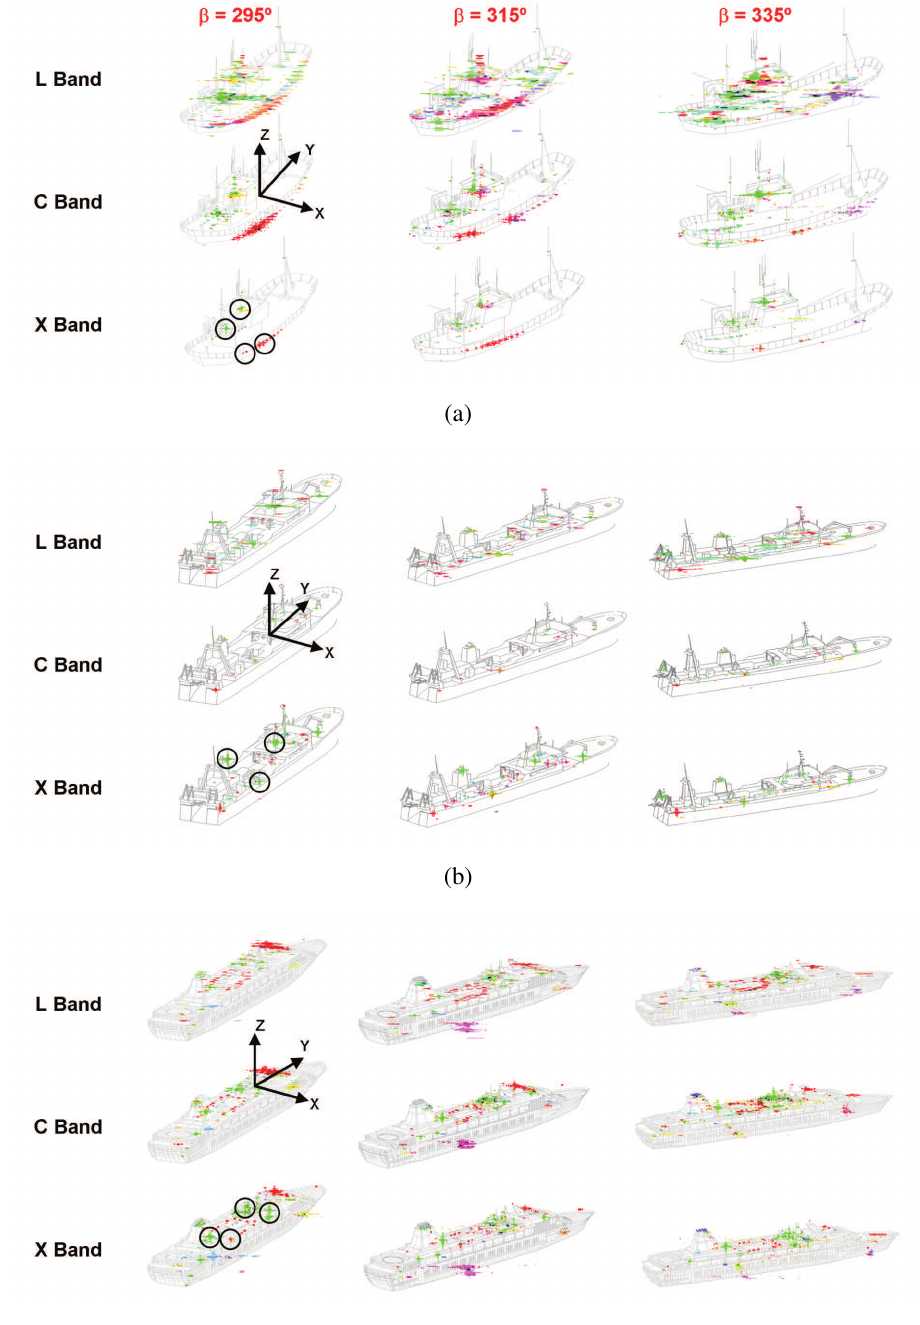
Figure 6. Scattering maps obtained for the SPA (a), ICE (b) and FER (c) vessels at L, C and X band with β ∈ { 295 , 315 , 335 } o and φ = 20 o . They have been analyzed with the Pauli CTD theorem for a dynamic range of 25 dB (red → 1 st channel, green → 2 nd channel, blue → 3 rd channel). The lengths of the SPA, ICE and FER ships are 30, 70 and 200 meters. Circles highlight PePS (stable dispersors) with which the feature sets of Table 1 are